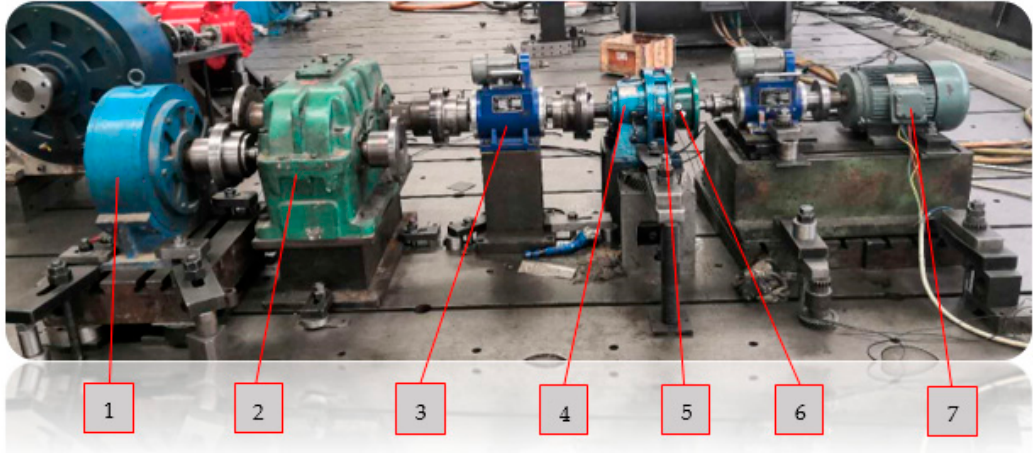
Figure 12. Experiment bench, 1—Magnetic Powder Loader; 2—Gear speed Increaser; 3—Torque and Rotational Speed Sensor; 4—Planetary Reducer; 5—Triaxial Acceleration Sensor #1; 6—Triaxial Acceleration Sensor #2; and 7—Triple-phase Asynchronous Motor.